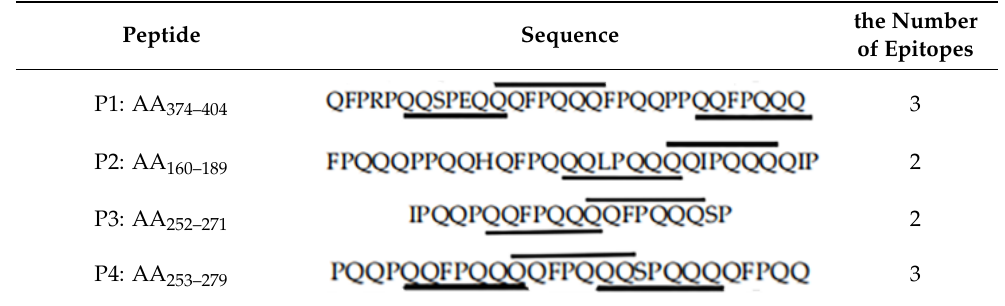
Table 2. Amino acids sequences of allergenic epitope-bearing peptides of ω -5 gliadin obtained by digestion of gliadin.